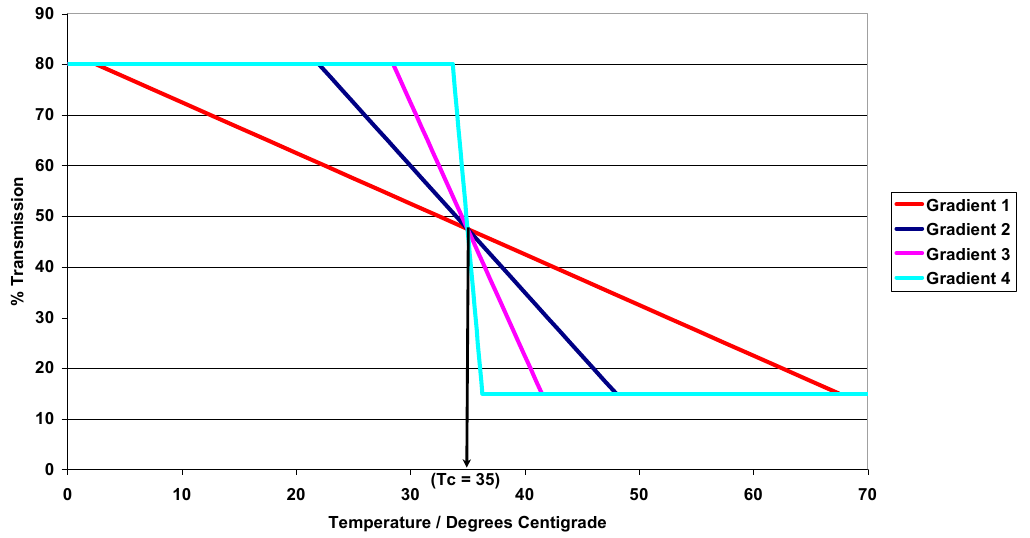
Figure 10. Theoretical hysteresis gradients used for modeling. T c = 35 °C for example shown. The gradients were created by varying the change in temperature between each 2.5% change in transmission/reflection. The gradients correspond to a ∆ T of 2.5, 1, 0.5 and 0.1 ˝ C giving gradients of ´ 1, ´ 2.5, ´ 5 and ´ 25 ∆ % Trans/ ∆ T as indicated in Table 4. Table 4. List of theoretical hysteresis gradients used for energy modeling.